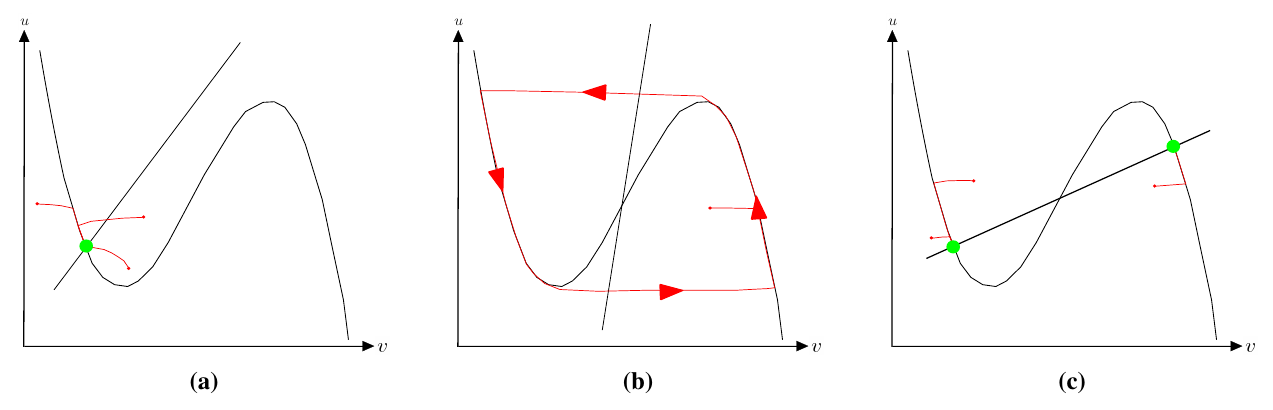
Figure 1. An overview of different nullcline configurations. The green discs represent stable states. Notice that the oscillatory configuration does not have any stable point. The red lines indicate the associated trajectories in the phases space for the particular initial condition.